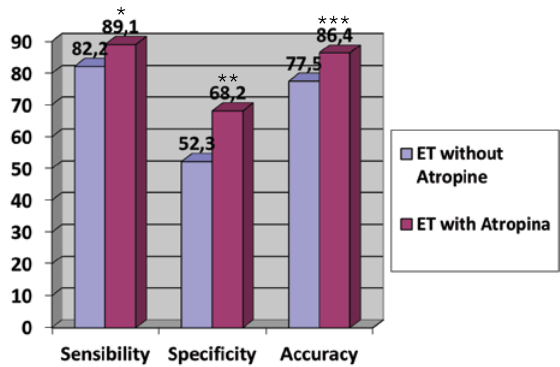
Figure 1. Sensibility, specificity and prognostic accuracy of ET with and without atropine in 450 patients. * p = 0.0033, ** p < 0.0001, and *** p = 0.008 versus ET without atropine,